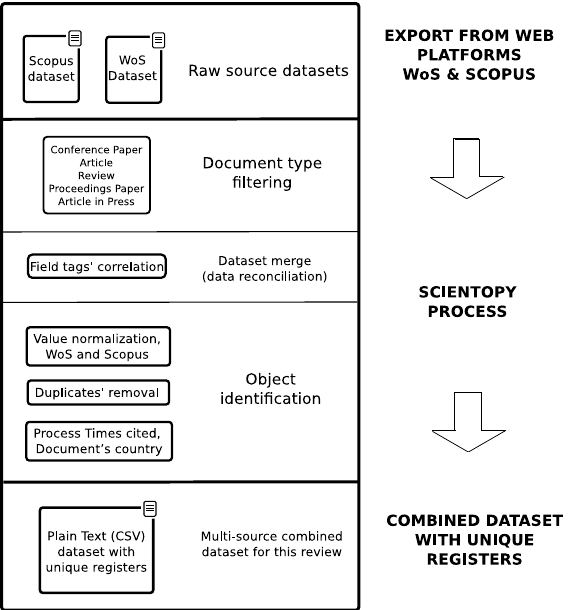
Figure 1. Data process to remove duplicates and obtain unique entries from the WoS and Scopus datasets, using ScientoPy